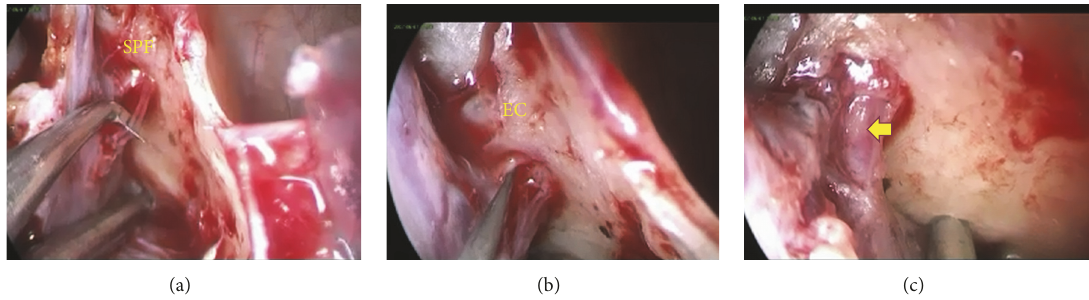
Figure 2: Intraoperative endoscopic view showing the branches of the posterior nasal nerve emerging from the SPF. (a) Resection of the anteroinferior branch toward the inferior turbinate. (b) Resection of the posterosuperior branch toward the middle meatus. (c) The SPA is well preserved after nerve resection (arrow). EC = ethmoidal